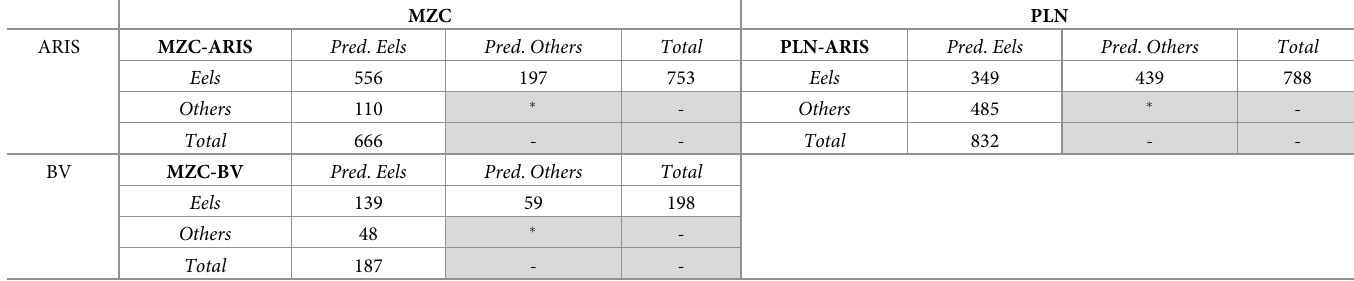
Table 3. Confusion matrices obtained for the Mauzac site/ARIS camera (MZC-ARIS), Mauzac site/BlueView camera (MZC-BV) and Port-La-Nouvelle site/ARIS camera (PLN-ARIS) datasets.